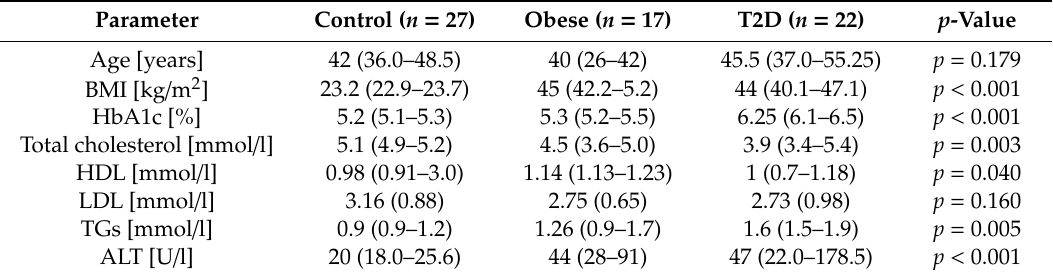
Table 2. Comparative characteristics of clinical data in treatment group and control